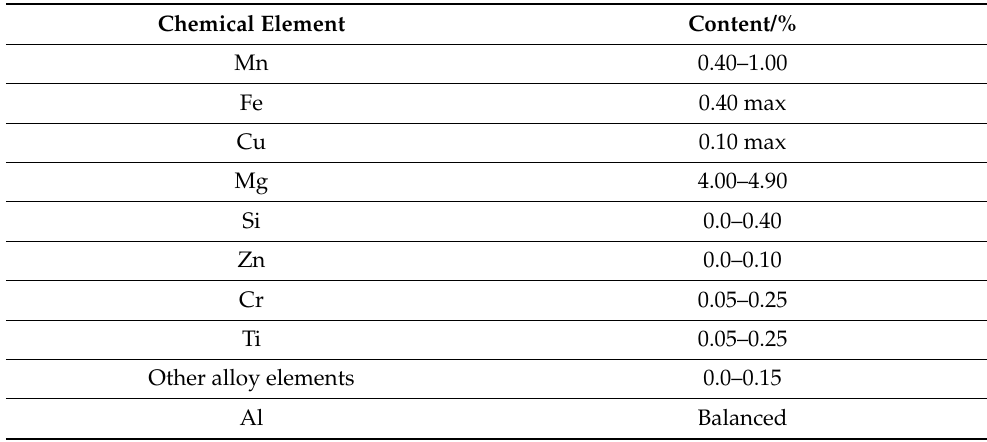
Table 1. Chemical composition of AlMg4.5Mn0.7